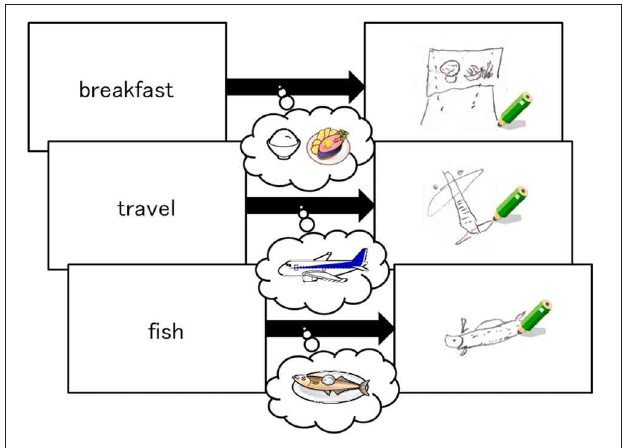
FIGURE 1 | Examples of participant’s figure drawings (right) of the target word